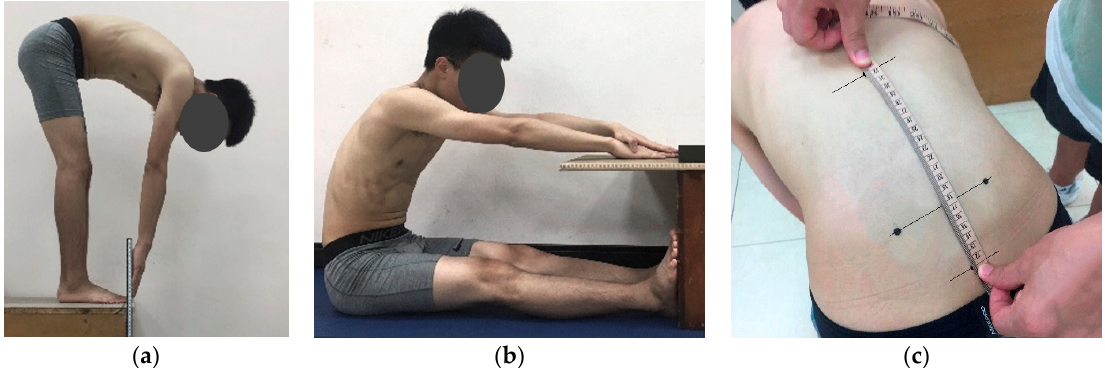
Figure 1. The three flexibility measurements employed in this study: ( a ) toe-touch test; ( b ) sit-and- reach test; ( c ) modified Schober’s test. test; ( c ) modified Schober’s